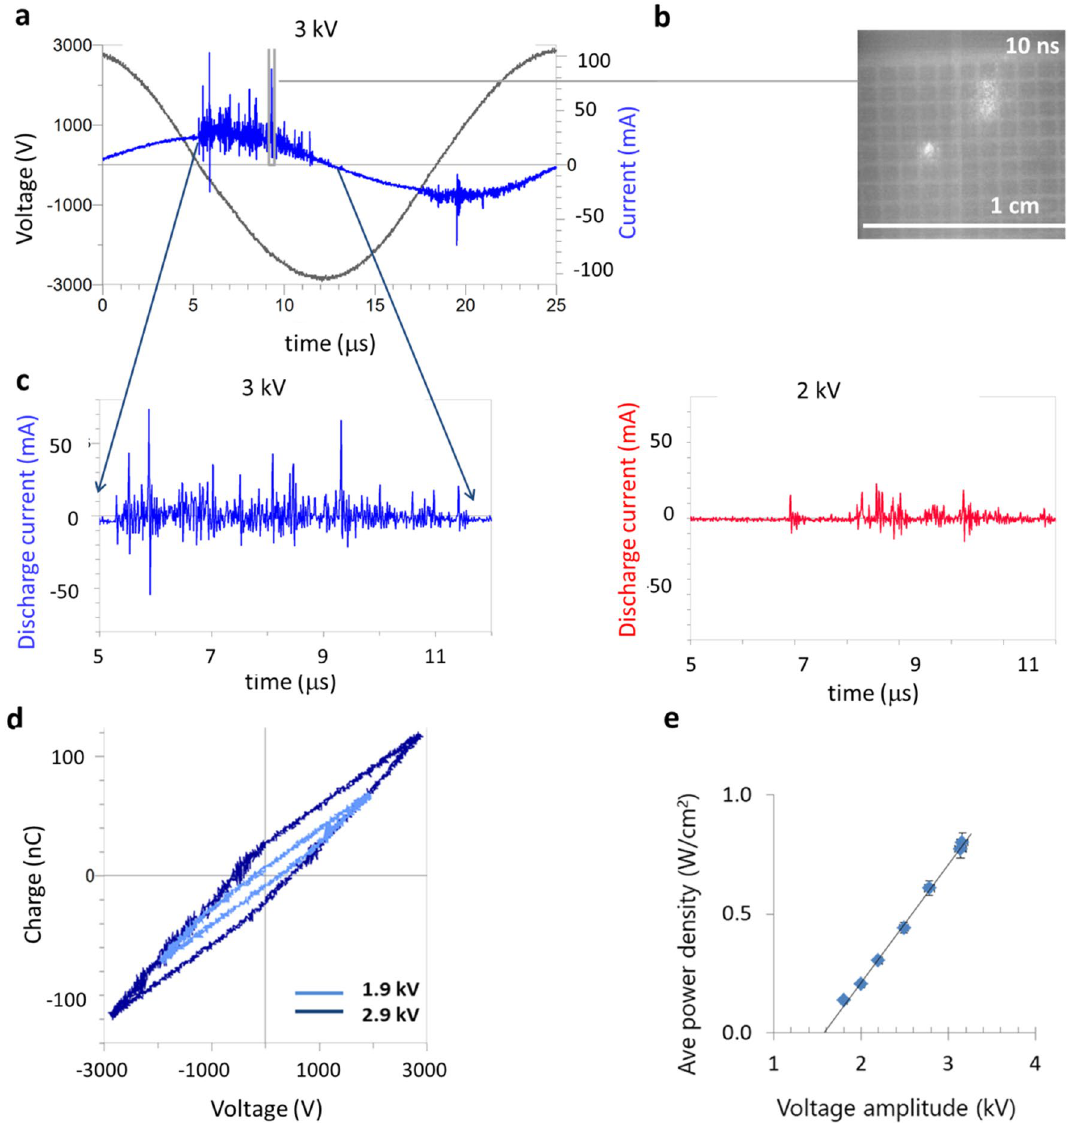
Figure 3. Electrical characteristics of the flex-DBD. ( a ) Current and voltage traces for one AC cycle. ( b ) Only three of ninety cavities are lit during a 10 ns exposure synchronized with an individual current pulse (marked in a). ( c ) The discharge current for one quarter of the cycle for applied voltage amplitudes of 3 kV and ( d ) for 2 kV. ( e ) From the Lissajous plots for one full cycle of the sinusoidal applied voltage we calculated that the 1.9 kV trial had 0.05 mJ/cycle and average discharge power of 0.3 W, while the 2.9 kV had 0.14 mJ/cycle and average discharge power of 0.75 W. ( f ) The average power increases linearly as a function of the applied voltage amplitude when the duty cycle and the frequency were kept constant at 20% and 40 kHz number of spikes occurring during the time when the mesh electrode acts as the anode, the voltage applied to the copper tape electrode is negative. In case of a positive mesh electrode, the electrons are able to flow into the anode and the current grows, but if the mesh electrode is negative, the electrons accumulate on the dielectric and the current stops resulting in lower current spikes. This asymmetry has been observed in plasma actuators that are a single edge surface DBD similar to the flex-DBD 20,35 . The number of individual discharges or current peaks varies depending on the maximum applied voltage (overvoltage). For example, the number of current peaks (over 10 mA) is 15 ± 8 at 2 kV and increases to 45 ± 8 for 3 kV (Fig. 3c). The greater number of current spikes results in a greater amount of charge transferred in the circuit as evident from the Lissajous plots (Fig. 3d). The Lissajous plot has a two-slope shape with a slight asymmetry due to a greater number of more intense discharges for the negative voltage (positive patterned electrode). The energy dissipated in the circuit per one cycle can be calculated as the area of the Lissajous plot, and the power is then determined using the frequency, f , the duty cycle, ν ,